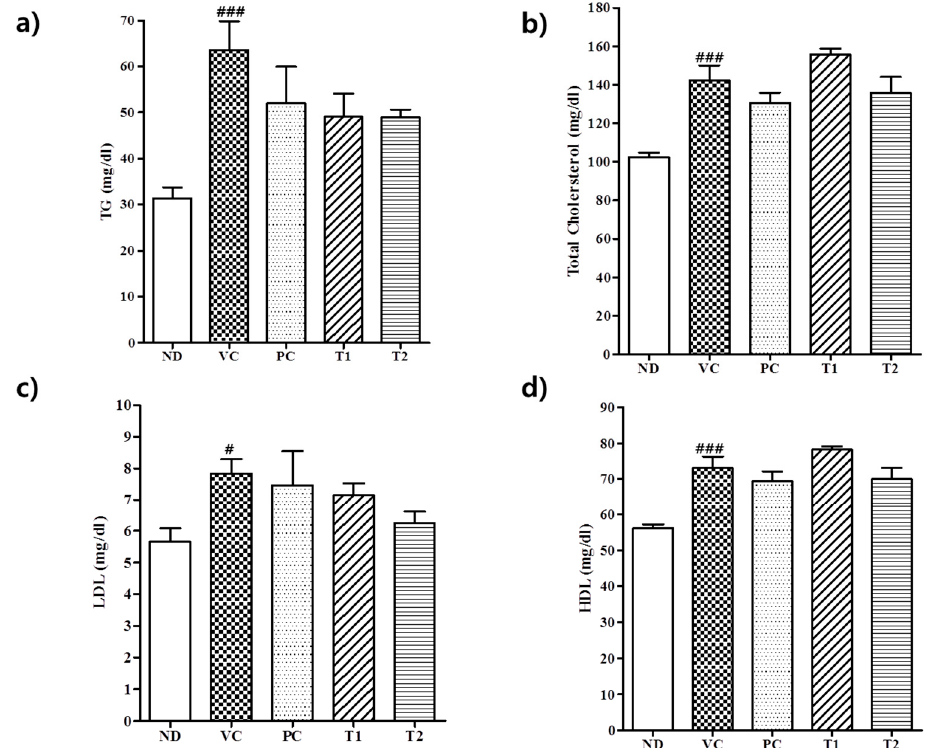
Figure 5. Effect of A. melanocarpa extract on serum lipid levels in HFD-induced obese mice. ( a ) Serum triglyceride (TG) levels. ( b ) Serum total cholesterol (TC) levels. ( c ) Serum low-density lipoprotein cholesterol (LDL) levels. ( d ) Serum high-density lipoprotein cholesterol (HDL) levels. Results are presented as means ± SDs ( n = 12); # p < 0.05 and ### p < 0.001 vs. the ND group. Group I (ND), normal diet group; Group II (VC), high-fat diet group; Group III (PC), Orlistat-treated group; and Group IV (T1), 100 mg/kg b.w. A. melanocarpa extract-treated group; Group V (T2), 200 mg/kg b.w. A. melanocarpa extract-treated